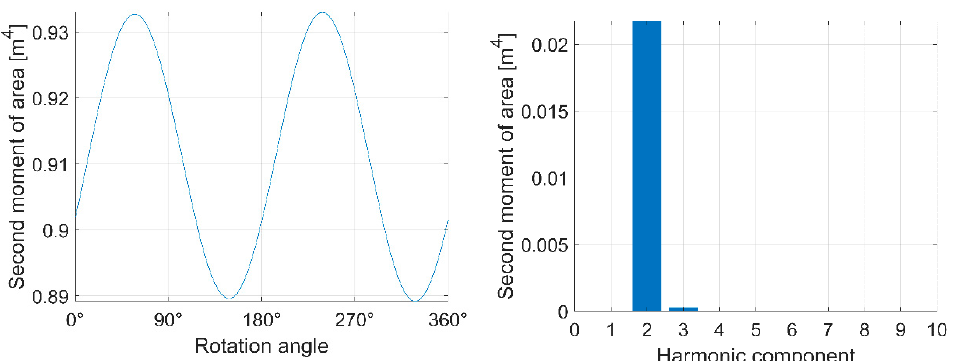
Figure 12. At the top, the variation of second moment of area for the generated solid profile in- Figure 12. On the left-hand side, the variation of the second moment of area for generated solid cluding components 3–50. At the bottom, the harmonic components of the variation. profile including components 3–50. On the right-hand side, harmonic components of the